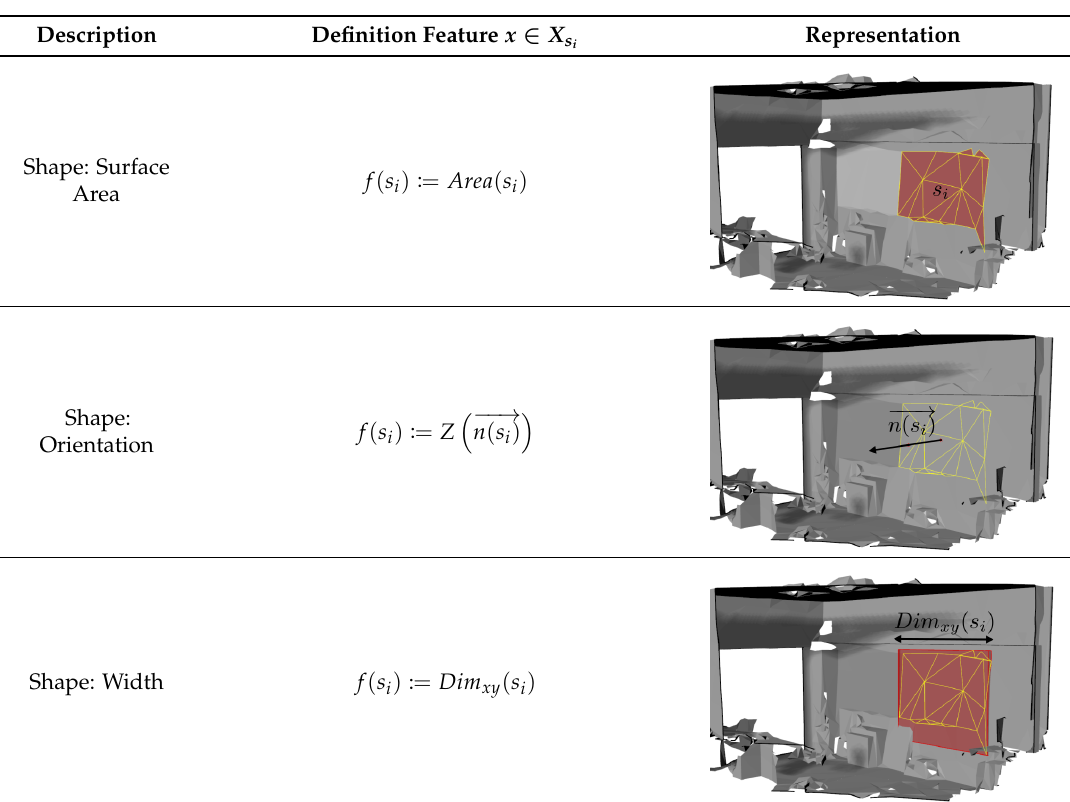
Table 2. Shape features extracted from each mesh/point cloud segment s i ∈ S